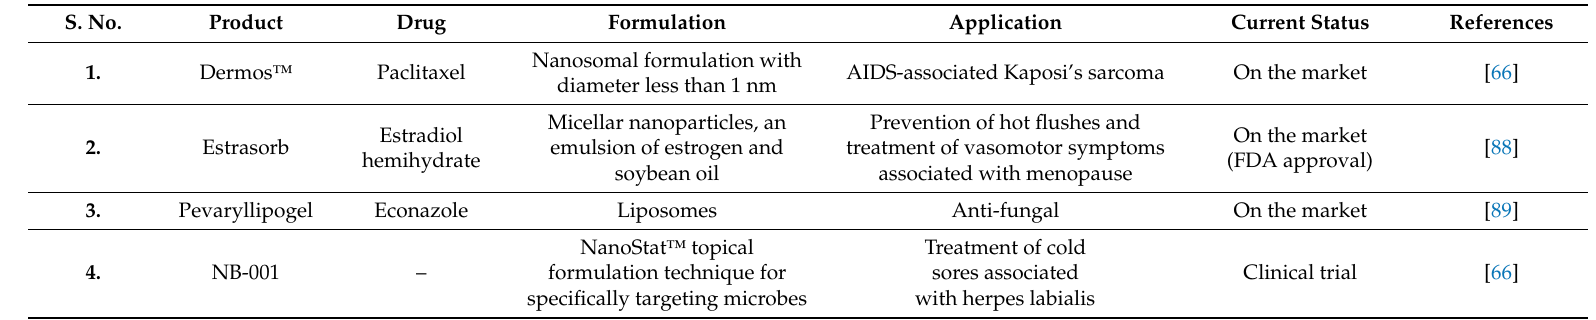
Table 2. Nanotechnology-driven products in clinical studies and market for topical